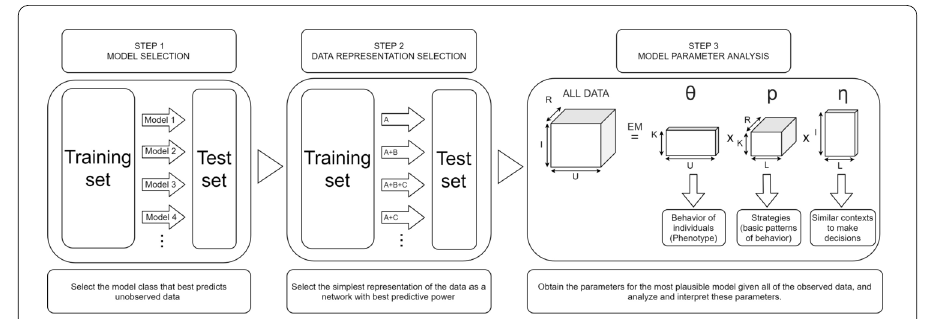
Figure 1 Methodological flow chart. Illustration of the workflow we follow in our work. Step 1: We identify the best model M (cid:2) using the predictive accuracy over unobserved data considering all plausible network representations of the data. Step 2: We select the network representation of the data that yields most accurate predictions of unobserved data compared to other data representations using M (cid:2) . Step 3: We consider all data and obtain the most plausible model parameters ( θ (cid:2) , η (cid:2) , p (cid:2) ) and analyze and interpret those parameters to understand decision making